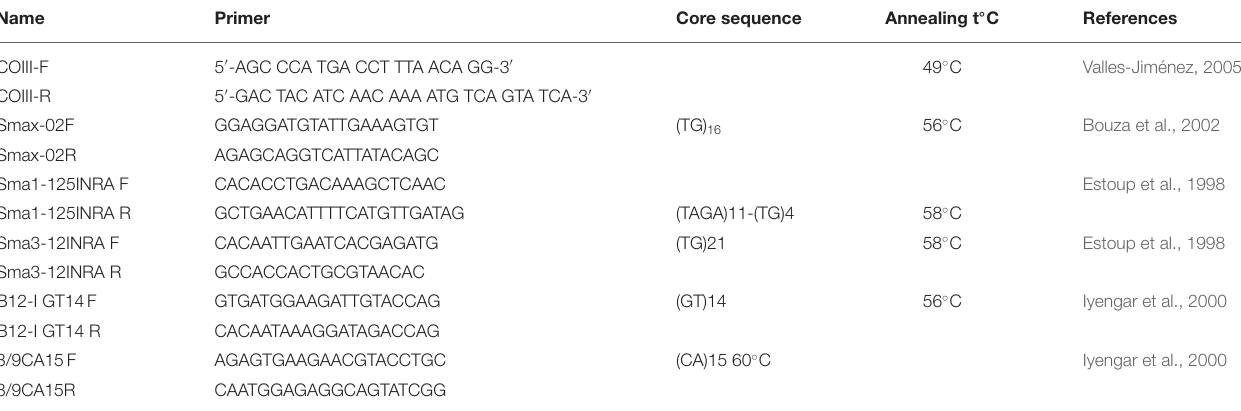
TABLE 1 | Set of primers and amplification conditions for the 5th microsatellite loci and universal COIII primers of